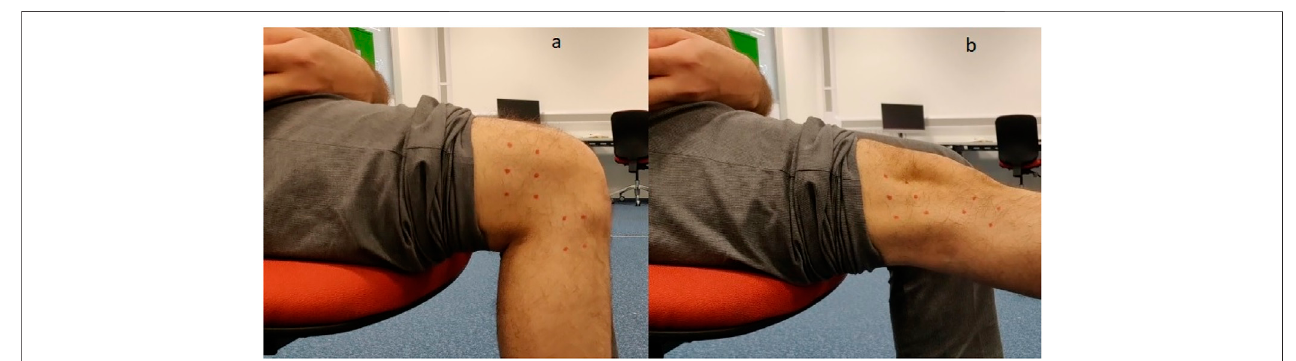
FIGURE 8 | Motion pro fi le test conducted on actual human knee: (A) knee in fl exion, (B) knee in extension.